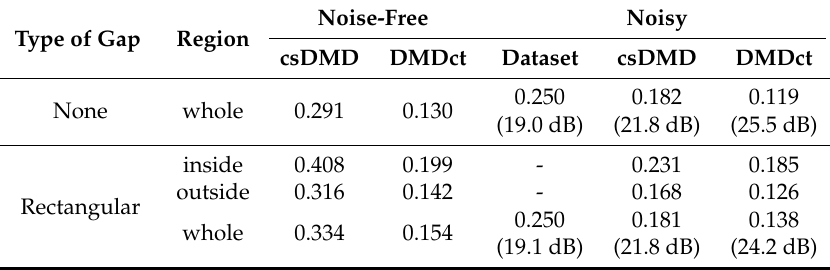
Table 1. The summary of the error metrics for the first random sampling mask. The numbers given are RMSE values with the PVNR values in dB shown inside parenthesis when applicable. In all cases studied, DMDct resulted in lower reconstruction error than csDMD.